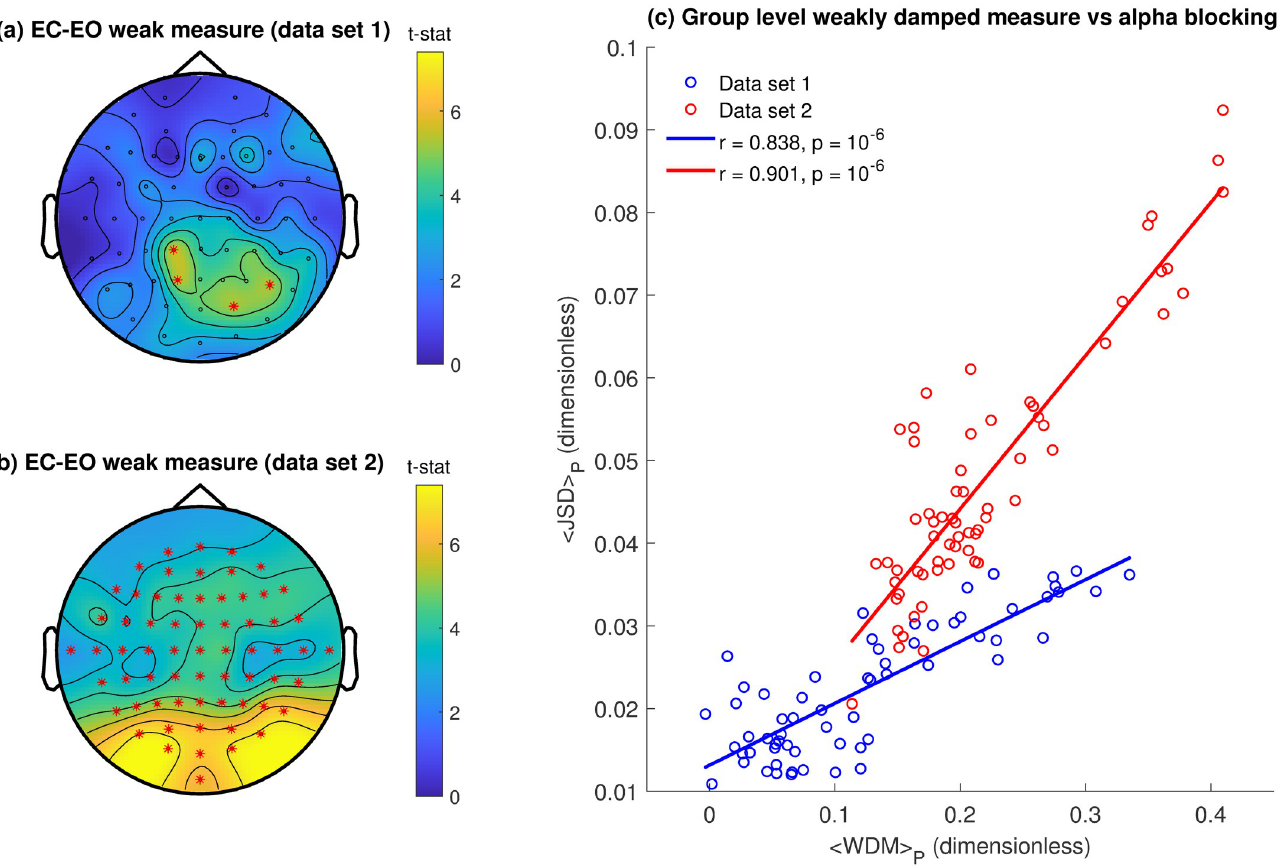
Fig 7. Alpha blocking is driven by changes in the distribution of alpha oscillatory damping. Topographic maps of mean difference between the weakly damped measure in EC and EO states (a) Data set 1 (b) Data set 2. Red asterisks indicate significant ( p < 0.05) differences in the weakly damped measure between EC and EO states calculated using the Max/Min-t permutation test (see Methods) and corrected for multiple comparisons. (c) Scatter plot of electrode-wise Jensen- Shannon divergence and the difference in the weakly damped measure between EC and EO, averaged across all participants in each data set (red = data set 1, blue = data set 2). In general the two measures are well correlated with each other: data set 1, r = 0.838, p = 10 − 6 ; data set 2, r = 0.901, p = 10 − 6 . Note that the group- level quantities differ between the data sets, in particular the < JSD > . The reason for this is not clear. It is possible that it is due to differing experimental configurations of the two studies, or more likely, it is due to a larger prevalence of strong alpha blockers in data set 2 (Fig 6j). Statistical significance was validated using a nonparametric permutation